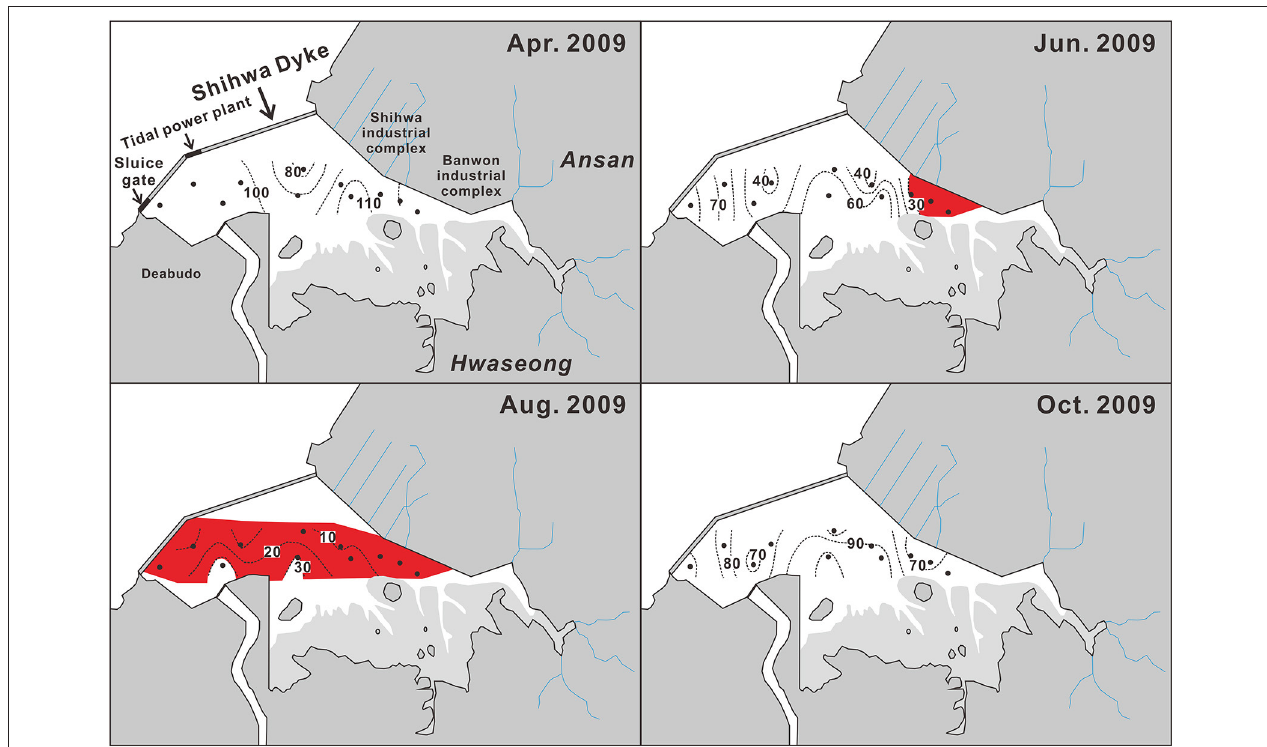
FIGURE 7 | Seasonal spatial distribution of bottom-water dissolved oxygen saturation (%) observed in 2009 in Shihwa Bay. Red areas represent hypoxic water (oxygen saturation < 30%). Black dots indicate sampling stations. The data source is the Ministry of Oceans and Fisheries report